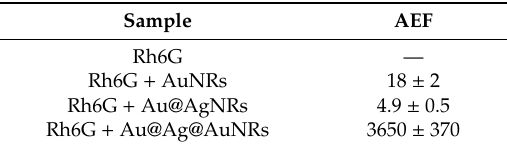
Table 2. Analytical enhancement factors (calculated based on Raman peak at 1510 cm − 1 ) for Rh6G